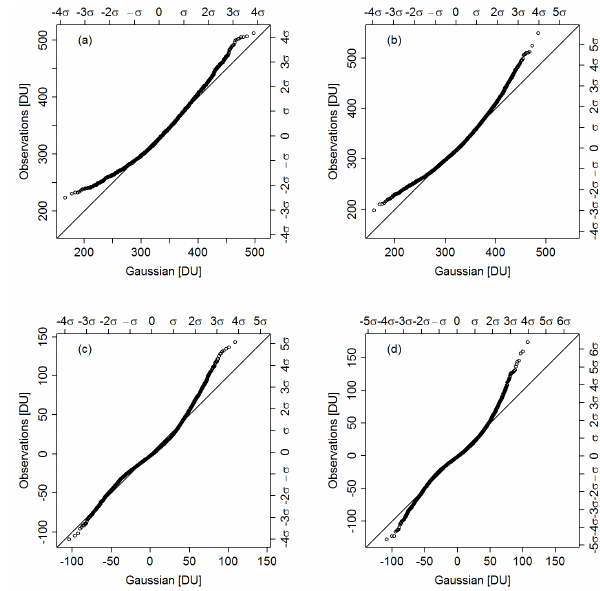
Fig. 2. Quantile-Quantile plots comparing (a) total ozone obser- vations at Arosa (Switzerland) with a Gaussian distribution (least- mean-square fitted to observations) for the period 1927–1959, (b) total ozone observations at Arosa (Switzerland) with a Gaussian distribution (least-mean-square fitted to observations) for the pe- riod 1960–2008, (c) remainder (deseasonalized and detrended to- tal ozone observations (by LOESS (STL) see Sect. 3.1 and Fig. 3d) at Arosa (Switzerland)) with a Gaussian distribution (least-mean- square fitted to observations) for the period 1927–1959 and (d) re- mainder (deseasonalized and detrended total ozone observations (by LOESS (STL) see Sect. 3.1 and Fig. 3d) at Arosa (Switzerland)) with a Gaussian distribution (least-mean-square fitted to observa- tions) for the period